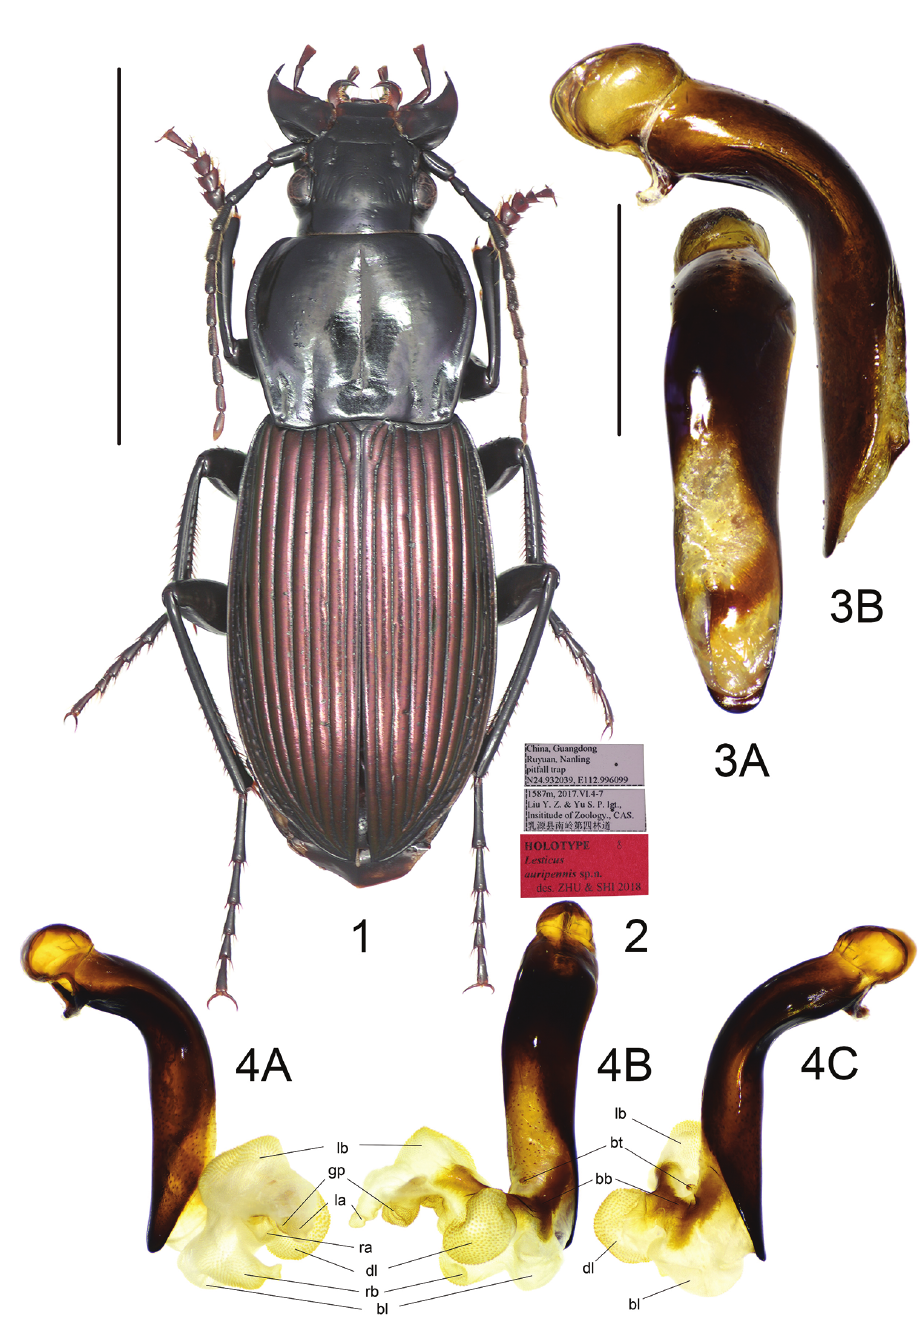
Figures 1–4. Lesticus auripennis sp. n. 1 habitus of holotype (male, Guangdong, IZAS), scale bar: 10.0 mm 2 labels of holotype 3 median lobe of aedeagus (holotype) A dorsal view B left-lateral view, scale bar: 2.0 mm 4 endophallus (holotype) A left lateral view B dorsal view C right lateral